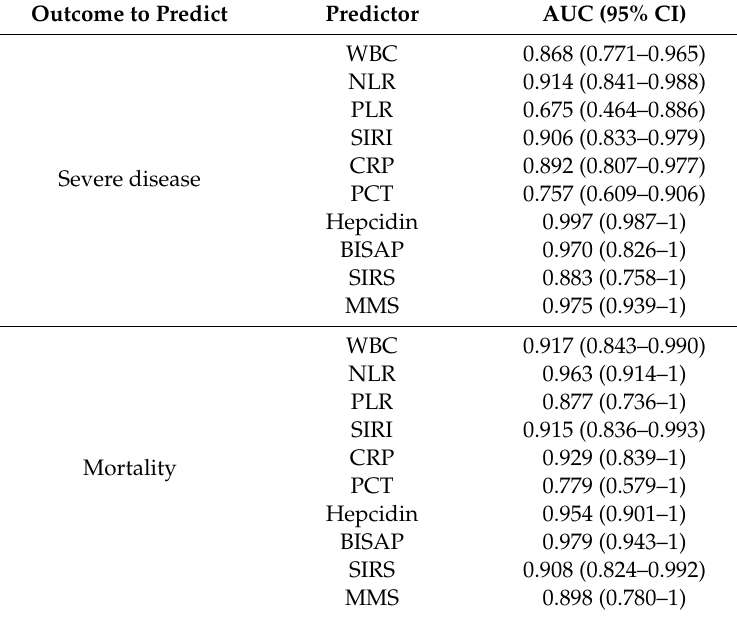
Table 4. Area under the receiver operating characteristics curve for the prediction of severe disease and mortality at 48